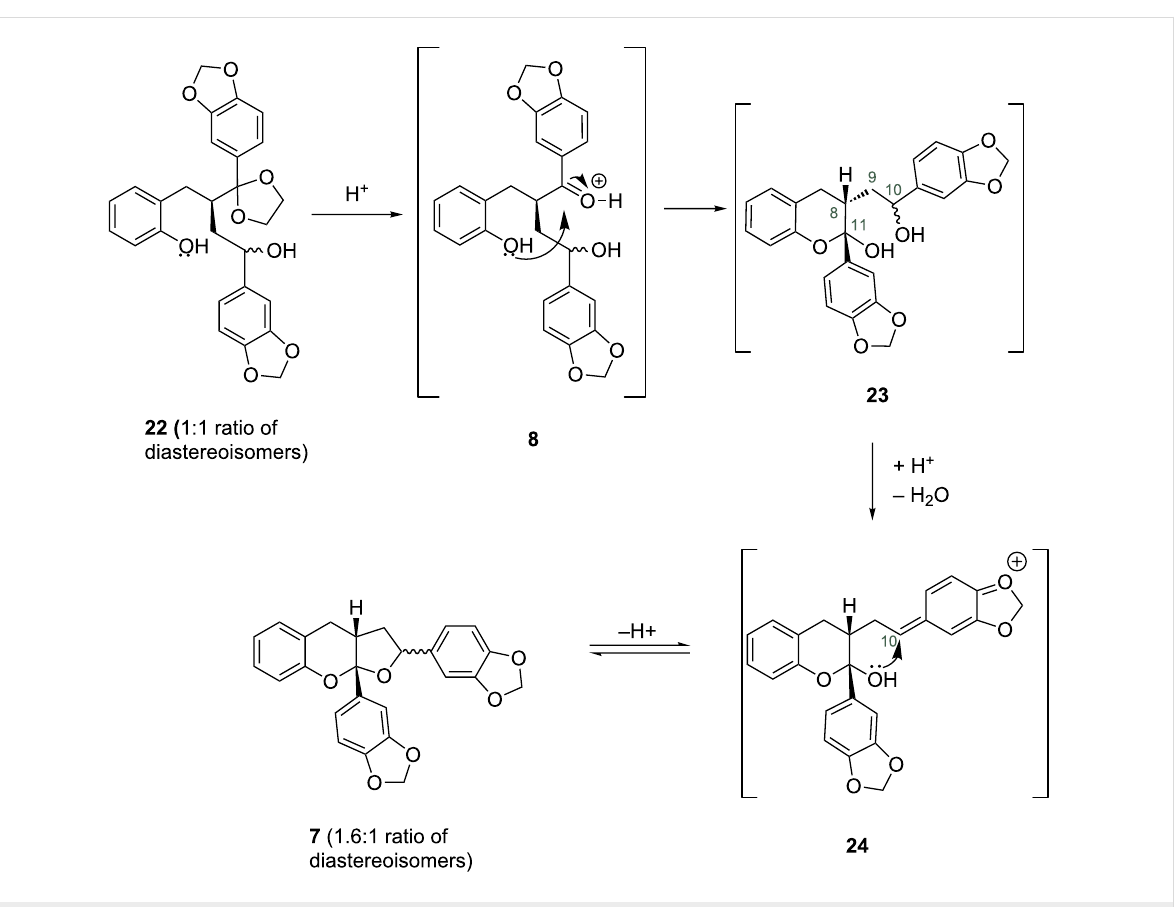
Figure 6: Possible mechanism for the formation of furo[2,3- b ]chromenes 7a and 7b